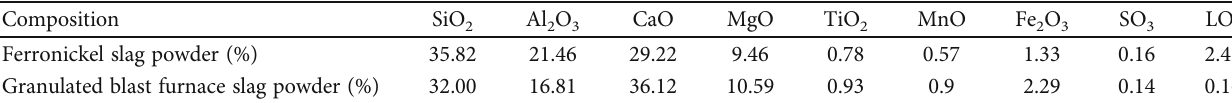
Table 3: Chemical composition of compound admixture.